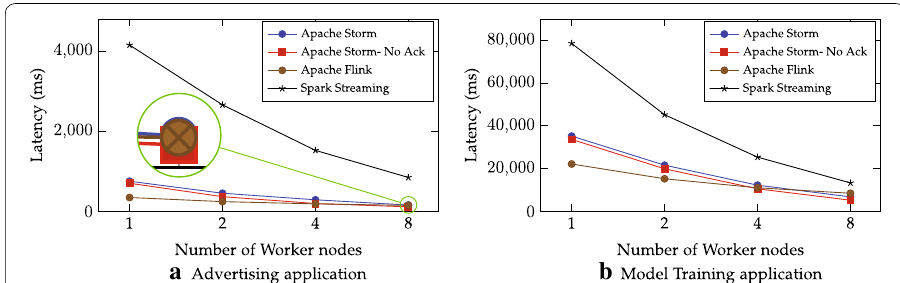
Fig. 17 Scalability comparison in terms of latency